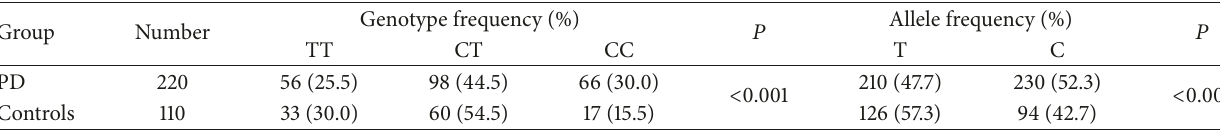
Table2:Frequencyofrs1014290inPDpatientsandcontrolsinaHansubpopulation.ThefrequencyofthenaturalCCgenotypeissignificantly higher in PD patients as compared to the controls, and less TT and CT genotypes are observed in PD patients. Analysis of C and T alleles revealed significant differences between